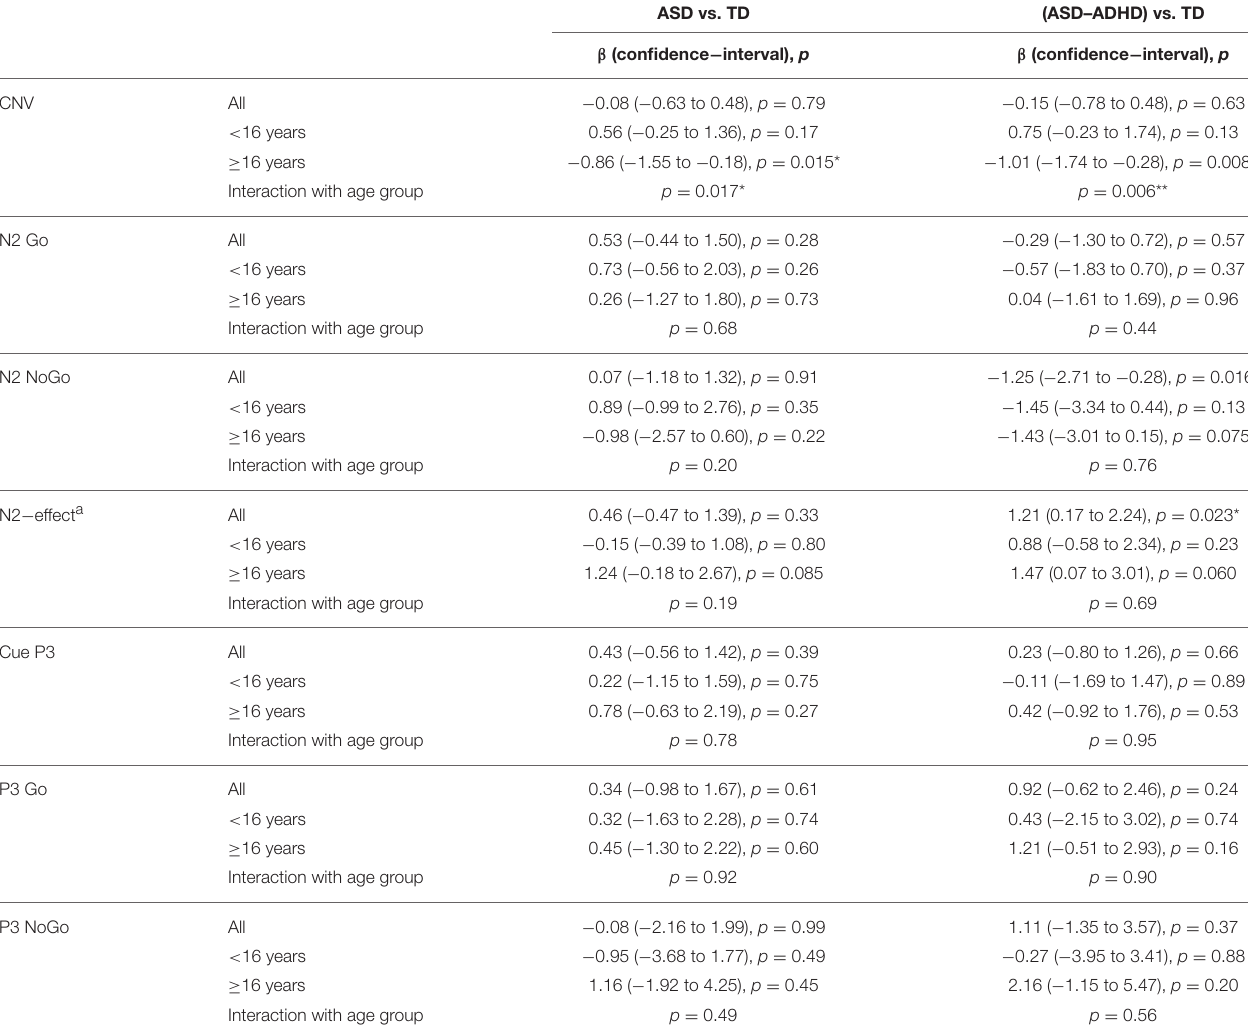
TABLE 4 | Mixed model analysis with the reported Event Related Potentials, ERPs, as dependent variables. ASD vs. TD (ASD–ADHD) vs.